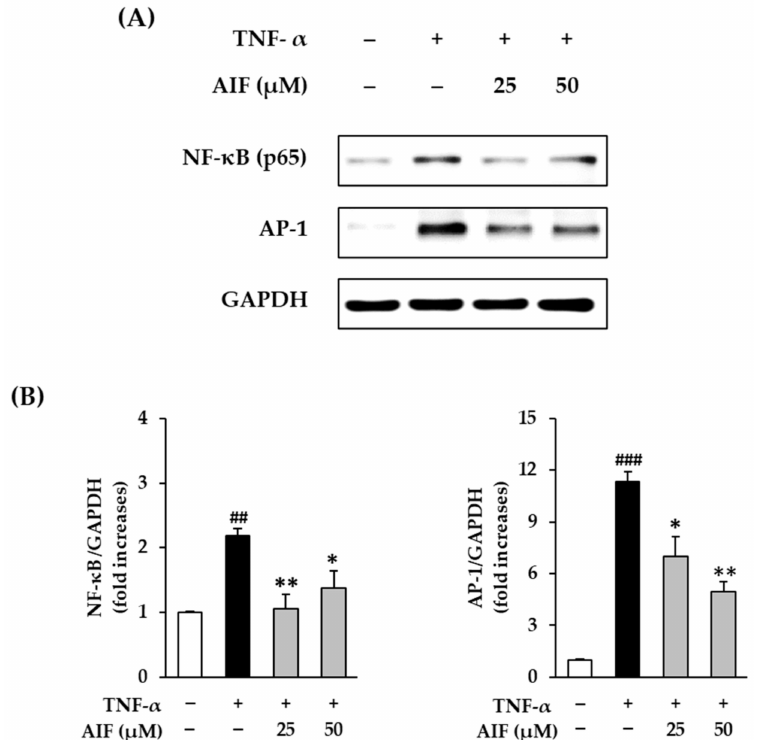
Figure 7. Inhibition of nuclear factor- κ B (NF- κ B) (p65) and activator protein 1 (AP-1) protein expres- sion by alpinumisoflavone (AIF) in tumor necrosis factor- α (TNF- α )-treated human dermal fibroblasts (HDFs). ( A ) Protein expression of NF- κ B, AP-1, and glyceraldehyde 3-phosphate dehydrogenase (GAPDH). ( B ) Relative protein expression levels of NF- κ B (p65) and AP-1. HDFs were challenged with 20 ng/mL TNF- α in the presence or absence of AIF (25 and 50 µ M) for 12 h. The protein expression was determined using Western blot analysis. The data are presented as mean ± SEM of at least three independent experiments. ## p < 0.01 and ### p < 0.001 as compared to untreated cells. * p < 0.05 and ** p < 0.01 as compared to TNF- α -treated